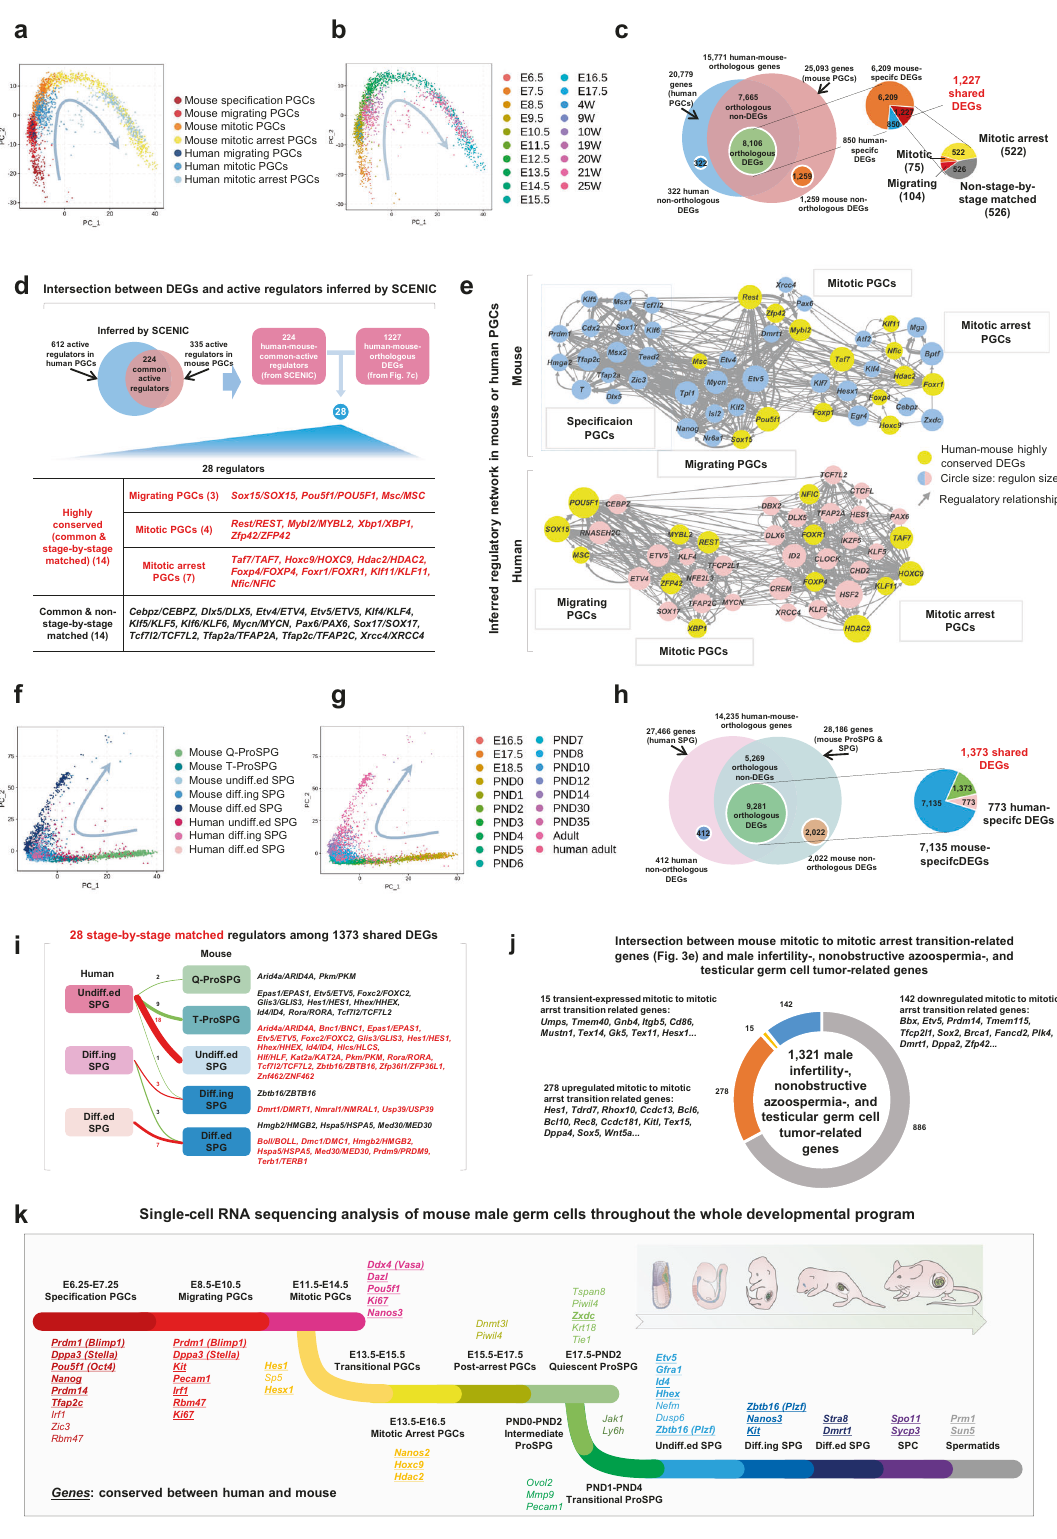
by-stage matched regulators were highly conserved in undiff.ed SPG (18), diff.ing SPG (3), and diff.ed SPG (7), respectively (Fig. 7i). In particular, HHEX, a critical regulator of mSSCs as functionally validated in this study, was highly expressed in both mouse and human undiff.ed SPG. FOXC2, and ETV5, two highly conserved regulators of undiff.ed SPG, were identi fi ed to be with regulatory potential in mouse and human (Supplementary